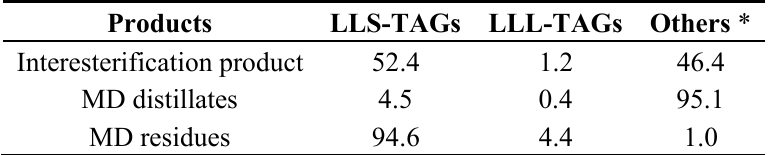
Table 1. Composition of fractions during preparation of SLCTs (mol%).